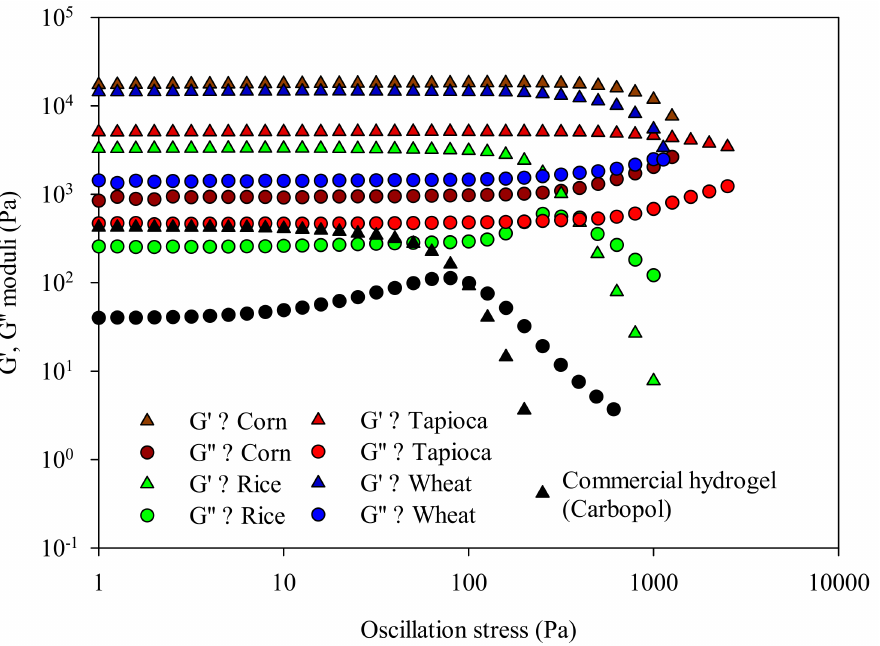
Figure 6. Influence of deformation stress on the viscoelastic responses (G (cid:48) , G” moduli) of starch-based hydrogels immediately after HPP